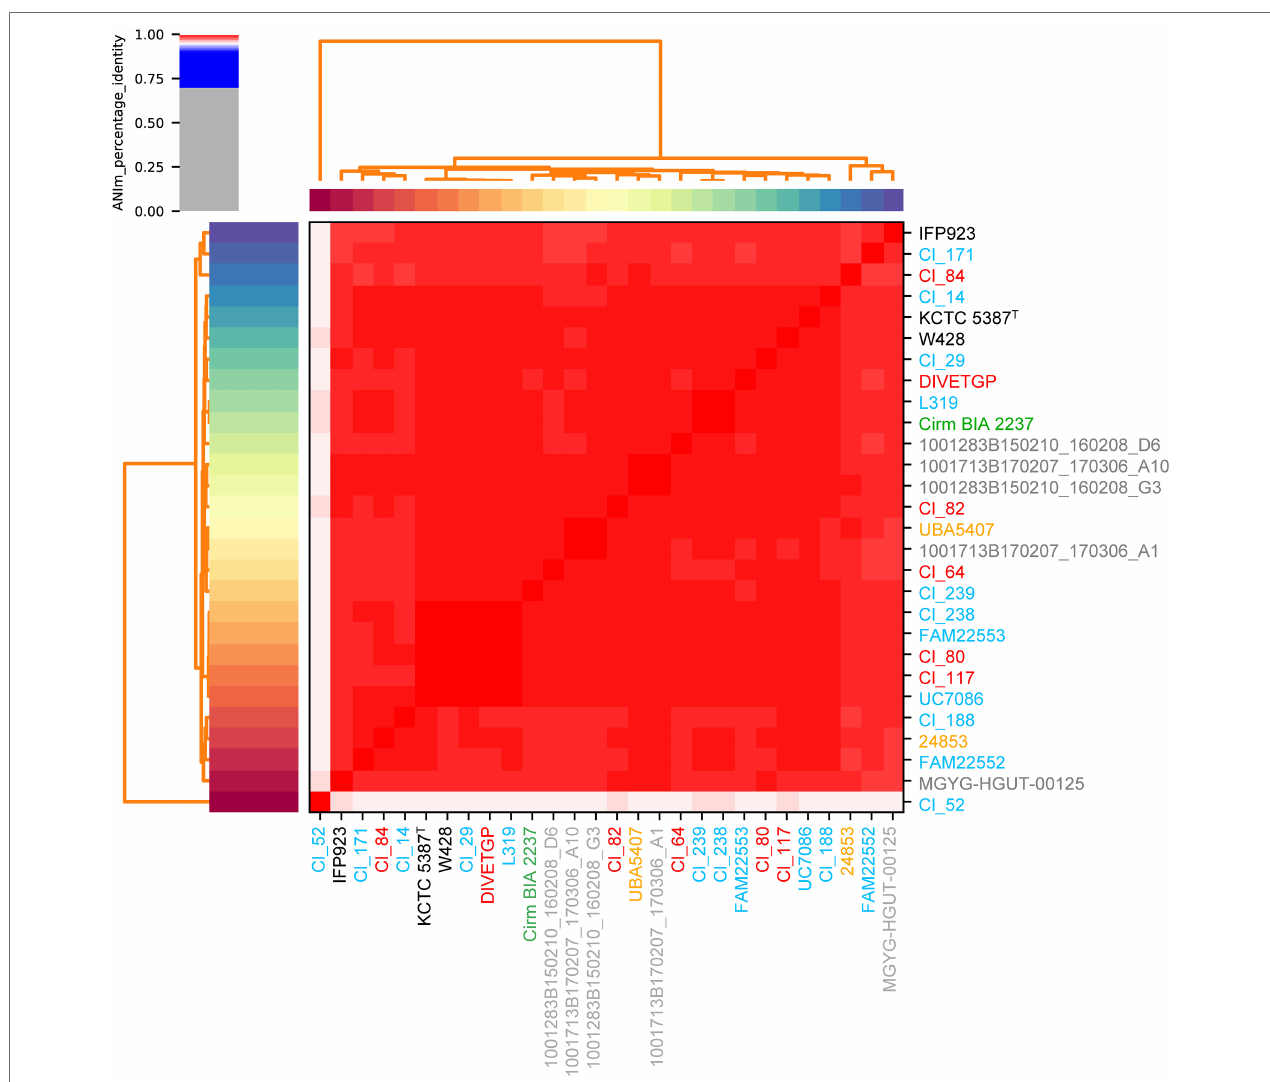
FIGURE 1 | Heatmap of the average nucleotide identity (ANI) of 28 Clostridium tyrobutyricum strains. ANIm analysis based on MUMmer alignment (Kurtz et al., 2004) of the genome sequences was performed and visualized using pyANI (see Footnote 4). The strain names are colored according to their isolation source, where red, blue, green, gray, and orange denote milk, cheese, silage, human, and mud, respectively. The type strain is indicated by the superscript capital